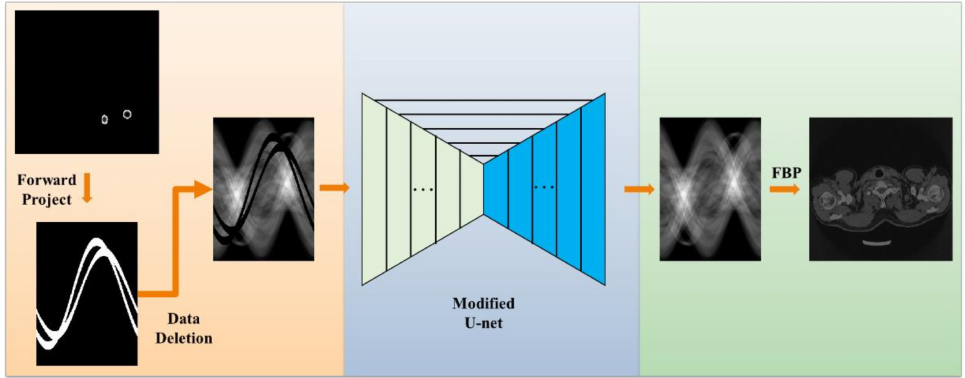
Figure 1. Workflow and major components of the proposed MAR